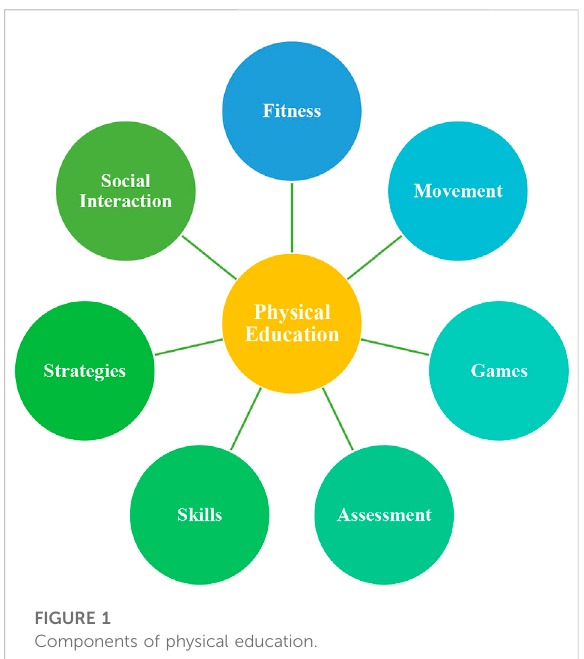
FIGURE 1 Components of physical